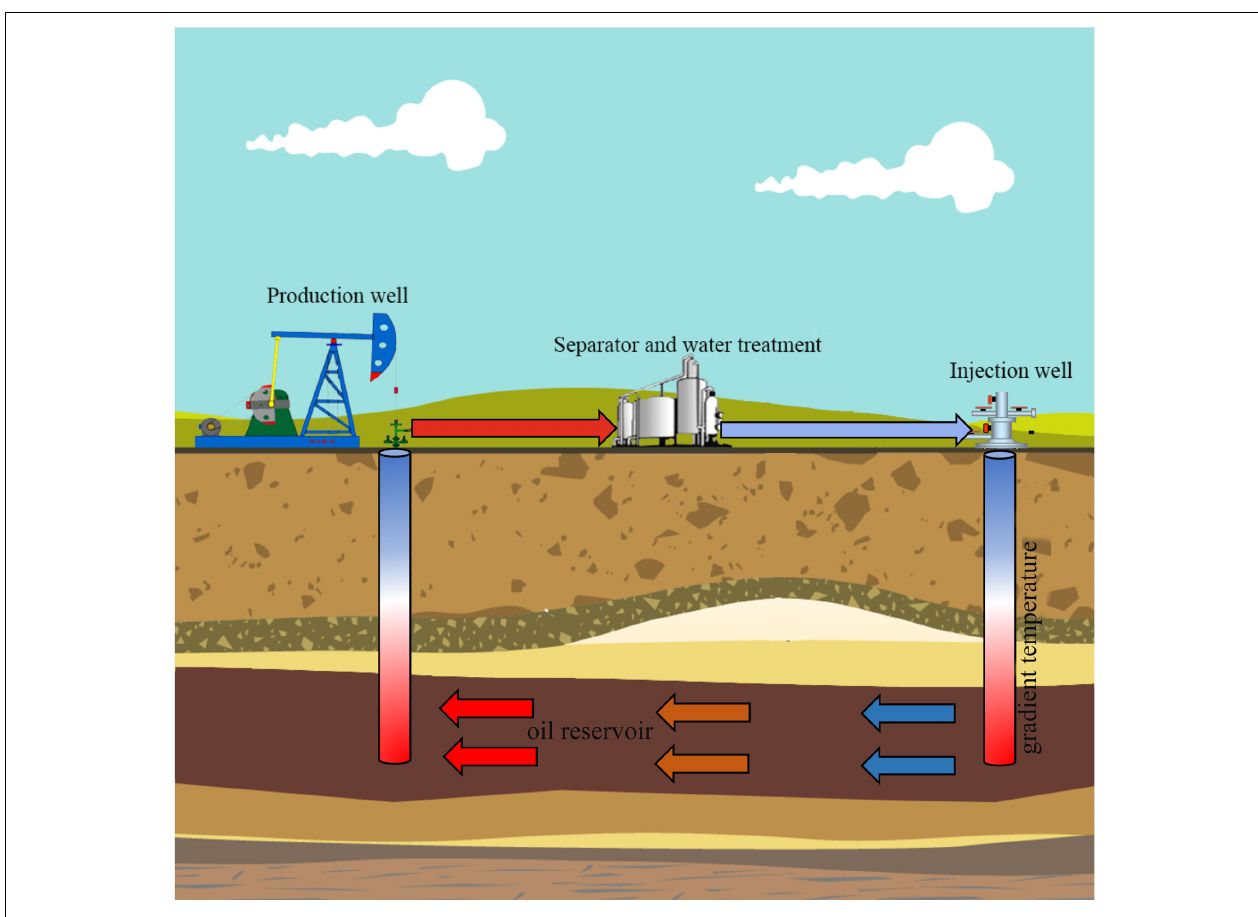
FIGURE 1 | Schematic diagram of temperature gradient in cyclic production system in petroleum